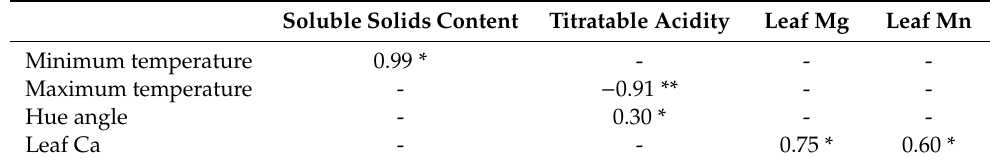
Table 8. Correlations between